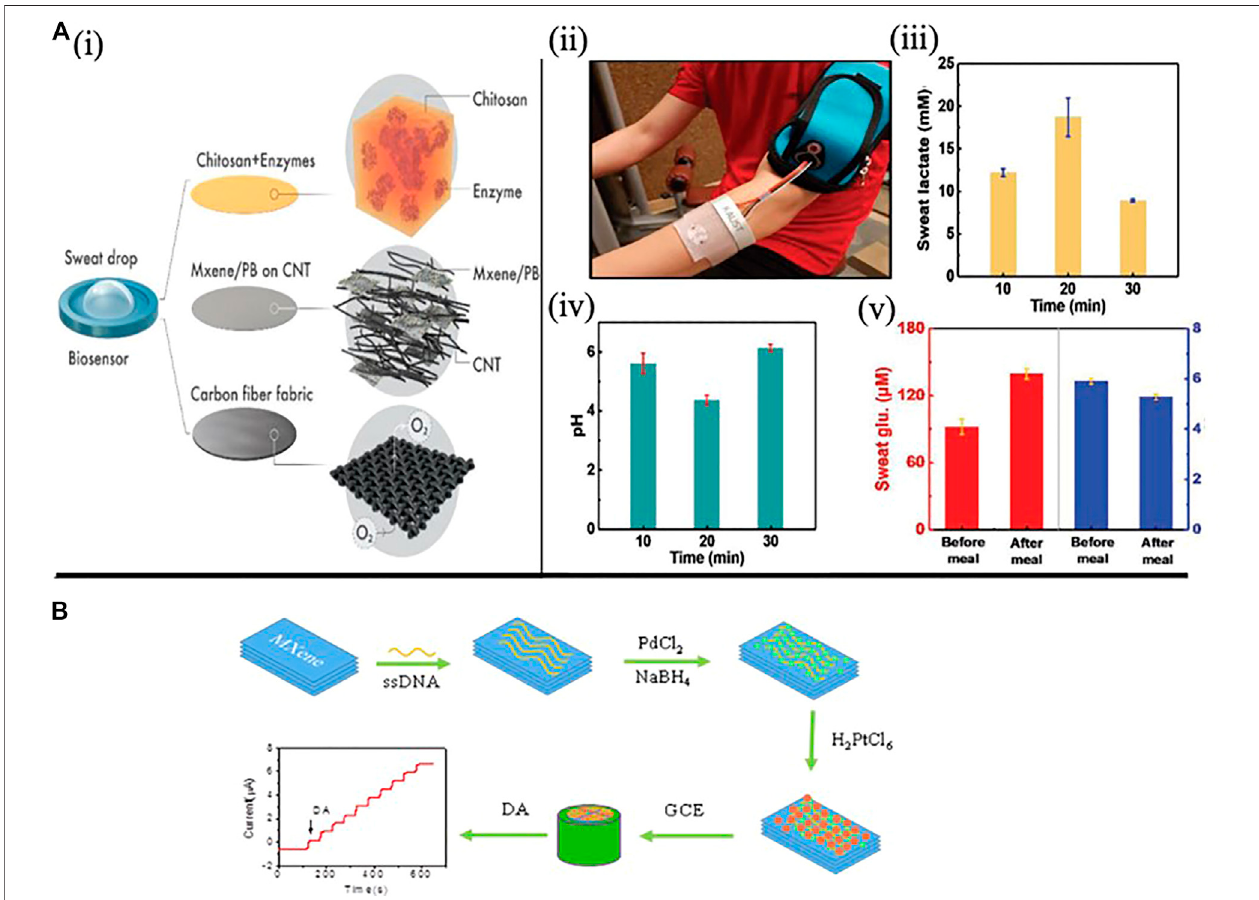
FIGURE 7 | (A) a wearable MXene based electrochemical biosensor. i) the oxygen-rich enzyme electrode is depicted schematically. ii) On the skin, sweat- monitoring wearable patch. iii) Comparison of lactate levels at various points during exercise using three separate lactate sensors. iv) Comparison of pH levels at